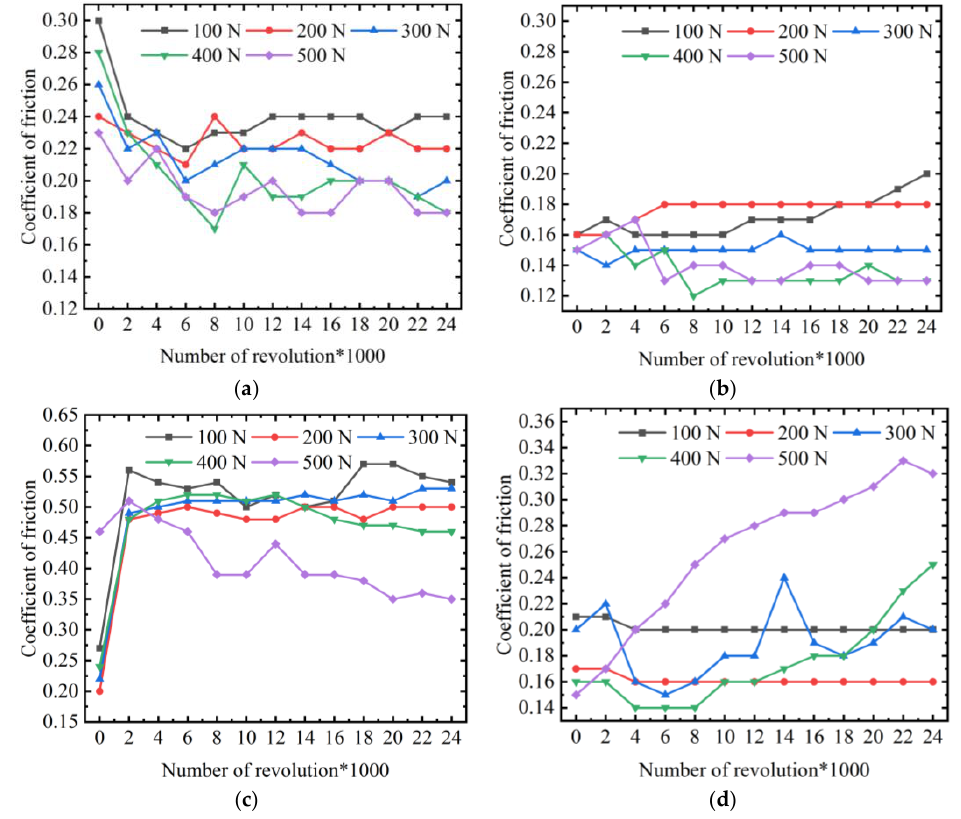
Figure 2. Friction coefficients of four materials under different loads: ( a ) aluminum bronze; ( b ) aluminum bronze-based ISSLB material; ( c ) tin bronze; ( d ) tin bronze-based ISSLB material. (Note: * means